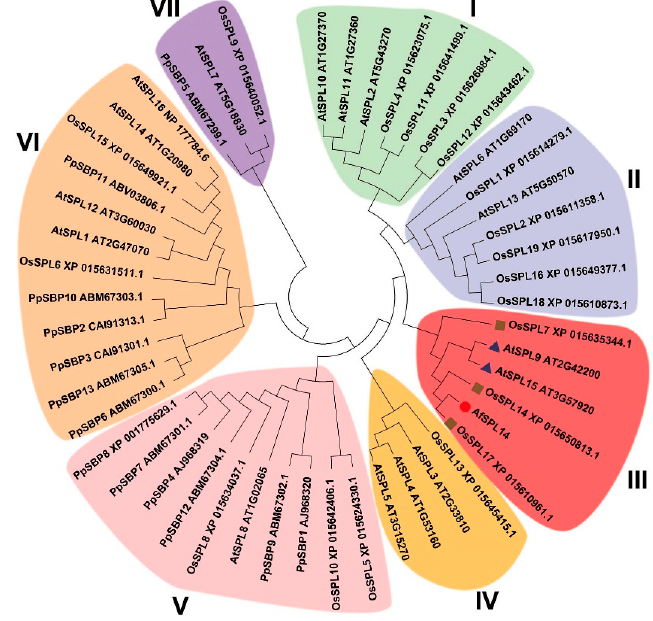
Figure 1. Phylogenetic analysis of AfSPL14 and SPLs of Arabidopsis , O. sativa and P. patens based on the conserved SBP domains. The unrooted tree was created using the neighbor-joining method with 1000 bootstrap replicates with 13 SBPs of P. patens , 16 SPLs of Arabidopsis , and 19 SPLs of O. sativa . The sequences of all these SBP domains are listed in Table S1.